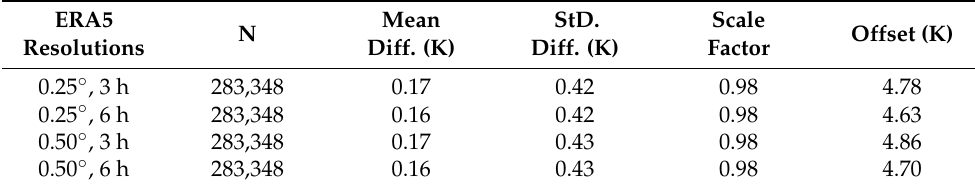
Table 1. Statistical parameters of the differences in SST skin derived from the Sentinel-3A SLSTR sensor